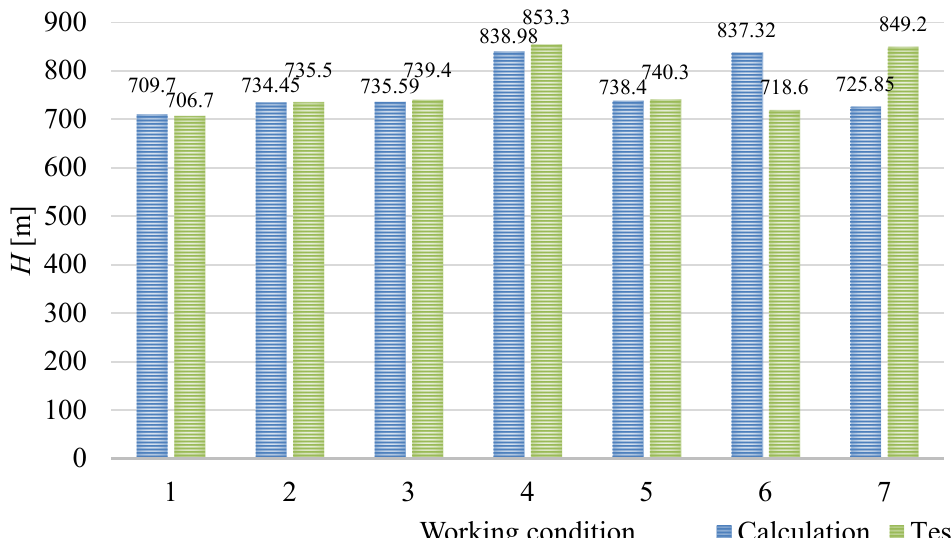
Figure 3. Calculation feasibility verification.